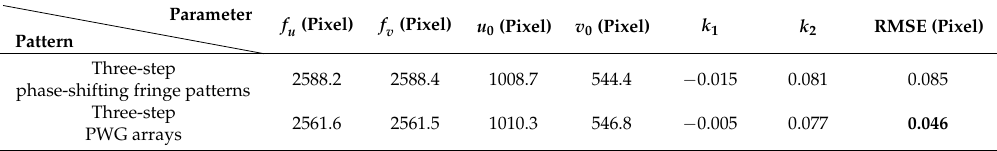
Table 2. Camera intrinsic parameters estimated from different phase-shifting patterns.